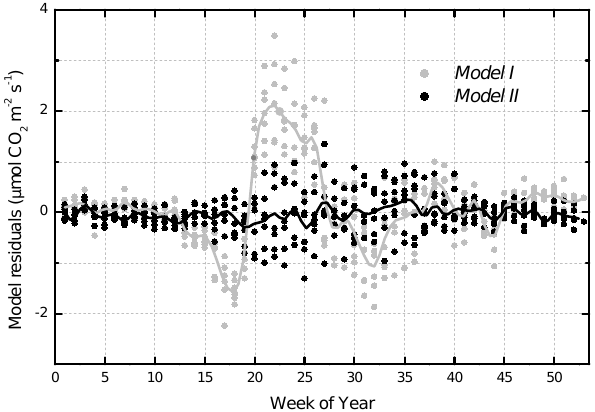
Fig. 4. Seasonal pattern of model residuals (mean errors) for the two empirical models (described in the method sections). Mean daily residuals (symbols) were grouped by weeks; the smoothed lines were calculated with a 14-day median